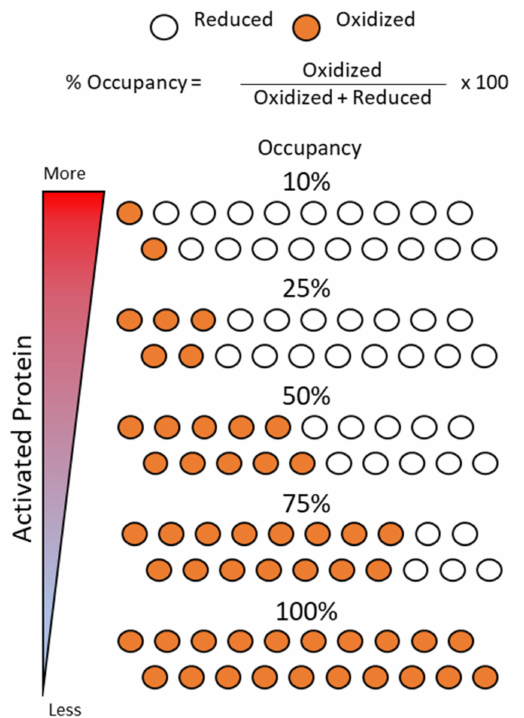
Figure 4. Thiol redox state and stoichiometry concept. For any given protein, the occupancy of oxidized versus reduced forms is determined by the ratio of oxidized over total abundance of protein analyzed (total sum of oxidized and reduced forms) and is used to interpret modification stoichiome- try. Multiple scenarios of increasing thiol oxidation are illustrated to represent how the stoichiometry of oxidative modifications can change. Depending on the type of modification and protein, thiol redox modifications can activate or inactivate a protein’s function. As an example, the heatmap gauge on the left side of the figure illustrates how changes in thiol oxidation stoichiometry can correlate with the amount of activated protein, where more oxidation leads to less activated